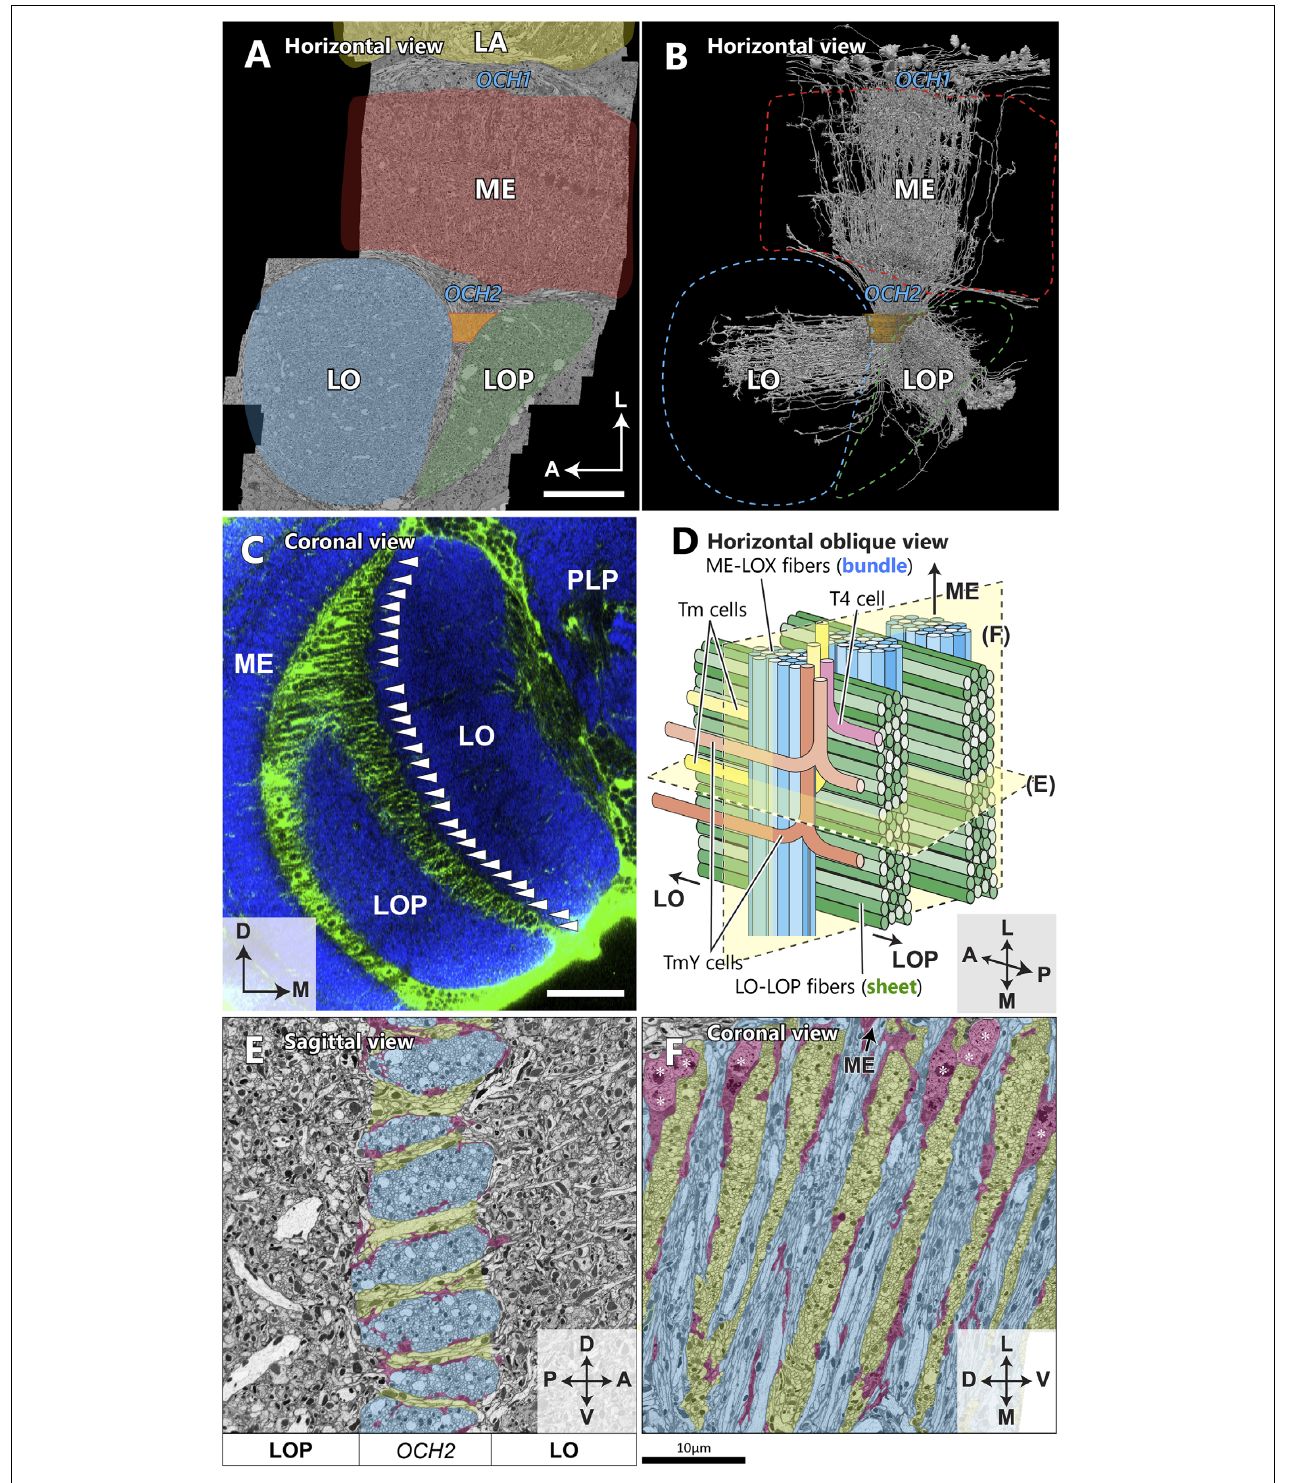
FIGURE 2 | Spatial orientation of the second optic chiasm. (A) A re-sliced cross section of the optic lobe imaged with FIB-SEM. The OCH2 region of interest (ROI) used for dense neuron annotation in this study is highlighted in orange. The ROI was set so that it covered 4 bundles and part of 5 sheets, and had a thickness along the L-M axis of 10.5 µ m, and a volume of ∼ 3,870 µ m 3 . (B) Skeletonized image of 1,225 columnar neurons ( ∼ 50% of all those we traced) which intersect the OCH2 ROI. Neurons were randomly selected for visualization. (C) A coronal section depicting glial processes in OCH2. Glial tissues (green) are labeled